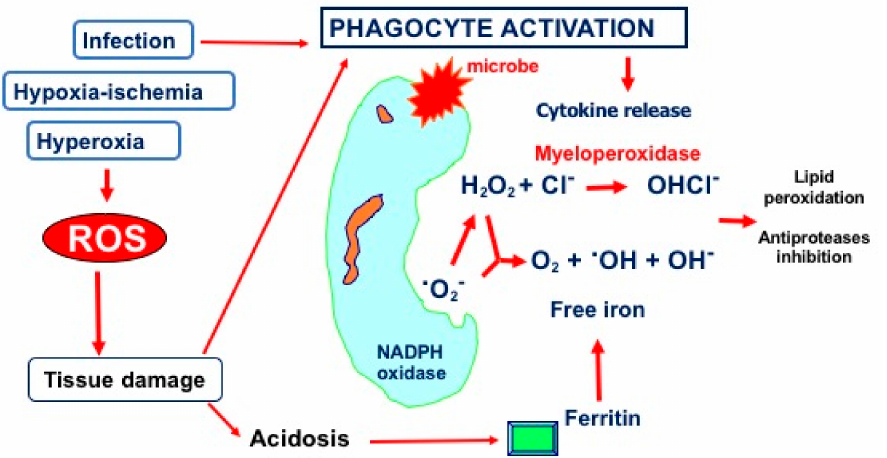
Figure 2. Schematic representation of free radical generation during phagocyte activation. Following injury, due to infection, hypoxia–ischemia, or hyperoxia, neutrophils release ROS. The superoxide anion ( · O 2 − ), the most abundant radical species, is the first stage of bacterial killing reaction, which is followed by generation of other ROS, such as hydroxyl radical ( · OH) by free irons and hypochlorous acid (OHCL − ) by myeloperoxidases.